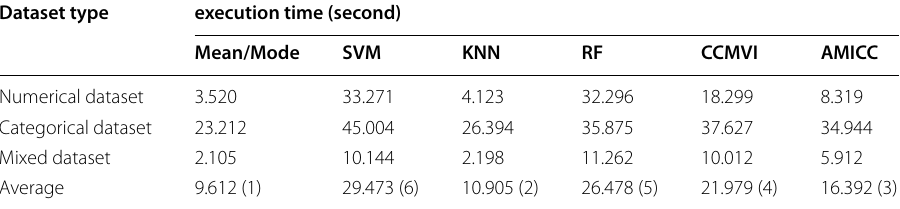
Table 14 Average execution time of the MVI methods